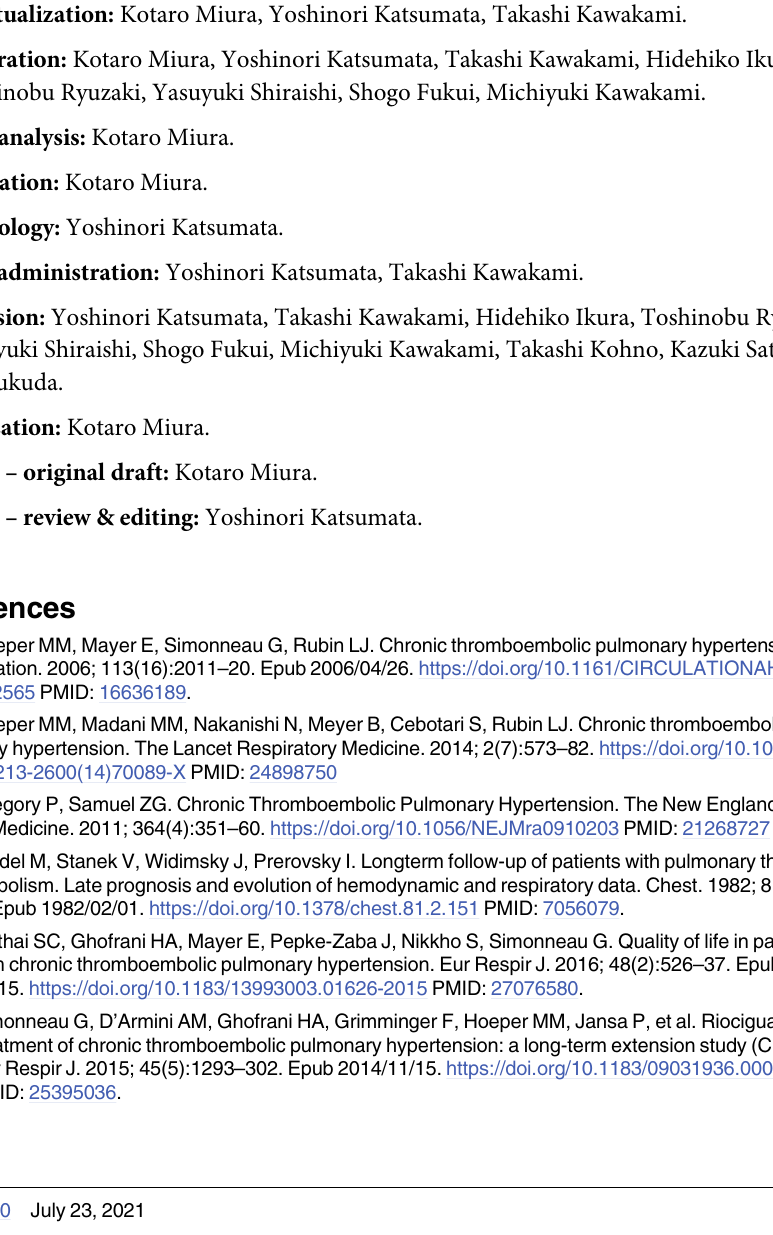
S1 Table. Changes of demographic data. BPA; balloon pulmonary angioplasty, TAPSE; tri- cuspid annular plane systolic